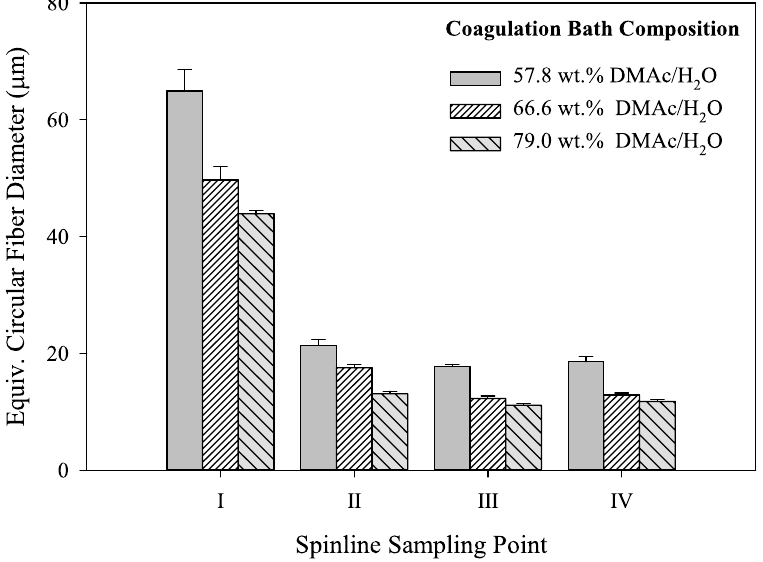
Figure 8. Graphical representation of equivalent circular diameters for the fibers shown in Figure 7 ( N ≥ 15 for each